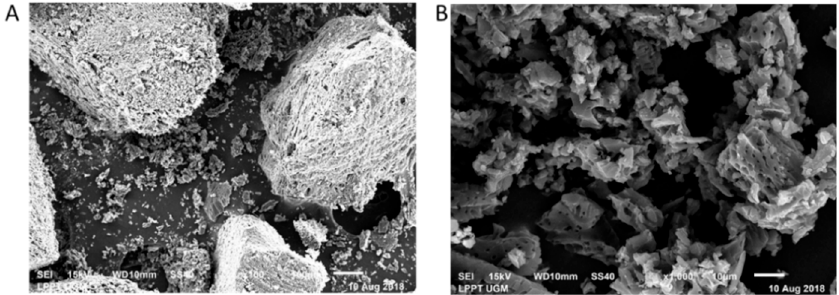
Figure 3. SEM micrograph of CSC-OX at 100× magnification ( A ) and 1,000× magnification ( B ).